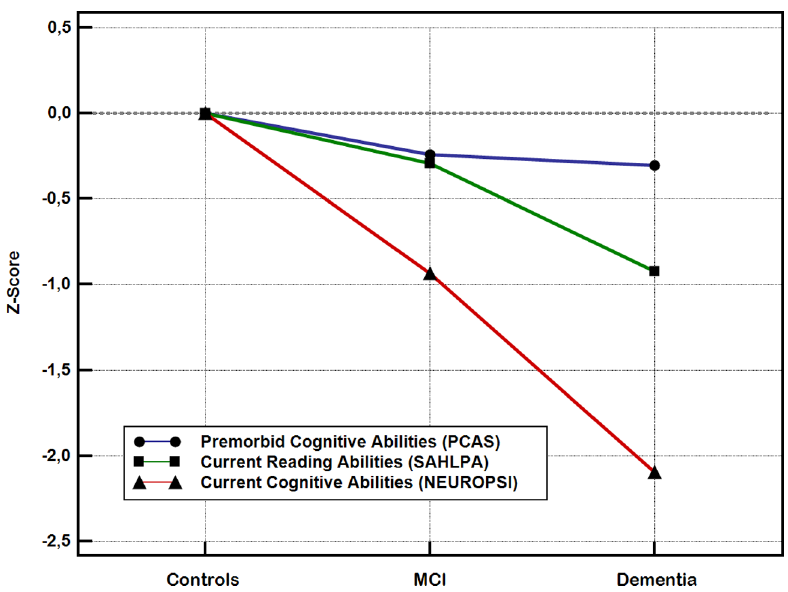
Figure 3. Between-group comparison of mean PCAS scores and construct criteria. Scores were transformed into z-scores to allow graphic comparison. Abbreviations: PCAS, Premorbid Cognitive Abilities Scale; SAHLPA, Short Assessment of Health Literacy for Portuguese-Speaking Adults; NEUROPSI, neuropsychological battery total score; MCI, Mild Cognitive Impairment.